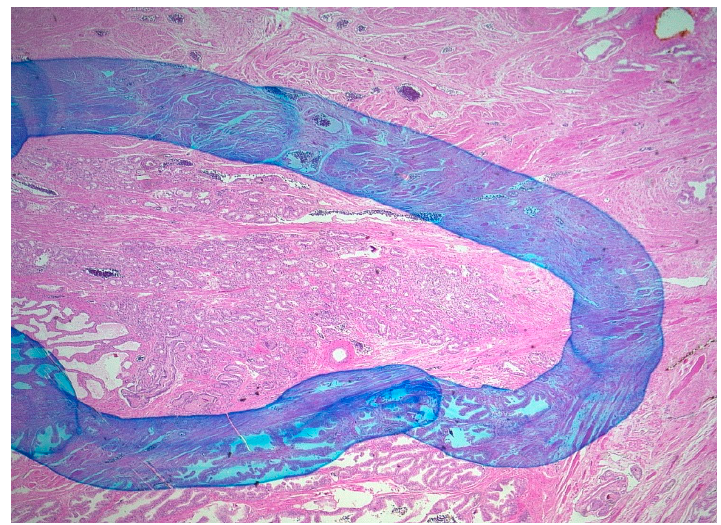
Figure 2. Outlining of the prostate carcinoma. (Hematoxyline-eosin stain; magnification: 20×).